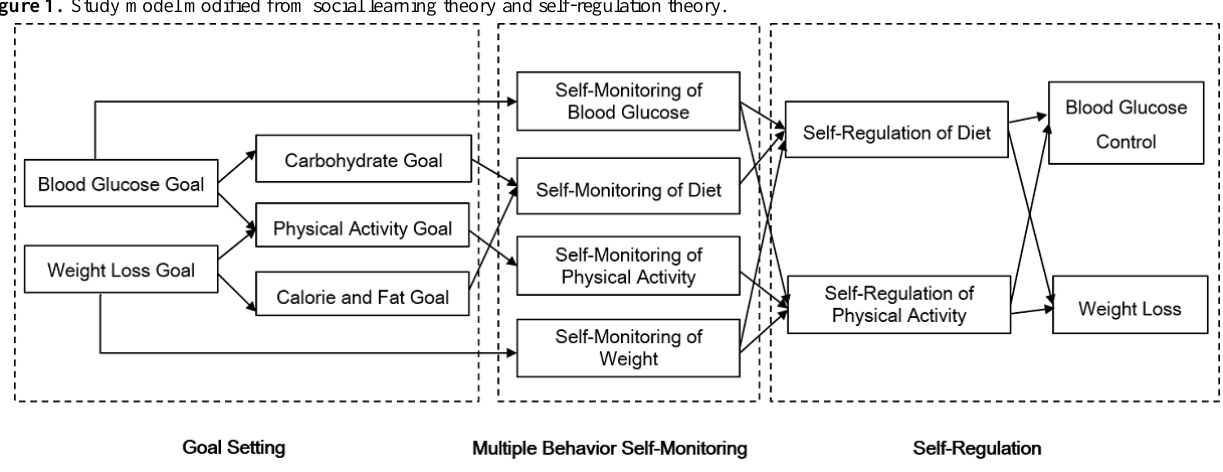
Figure 1. Study model modified from social learning theory and self-regulation